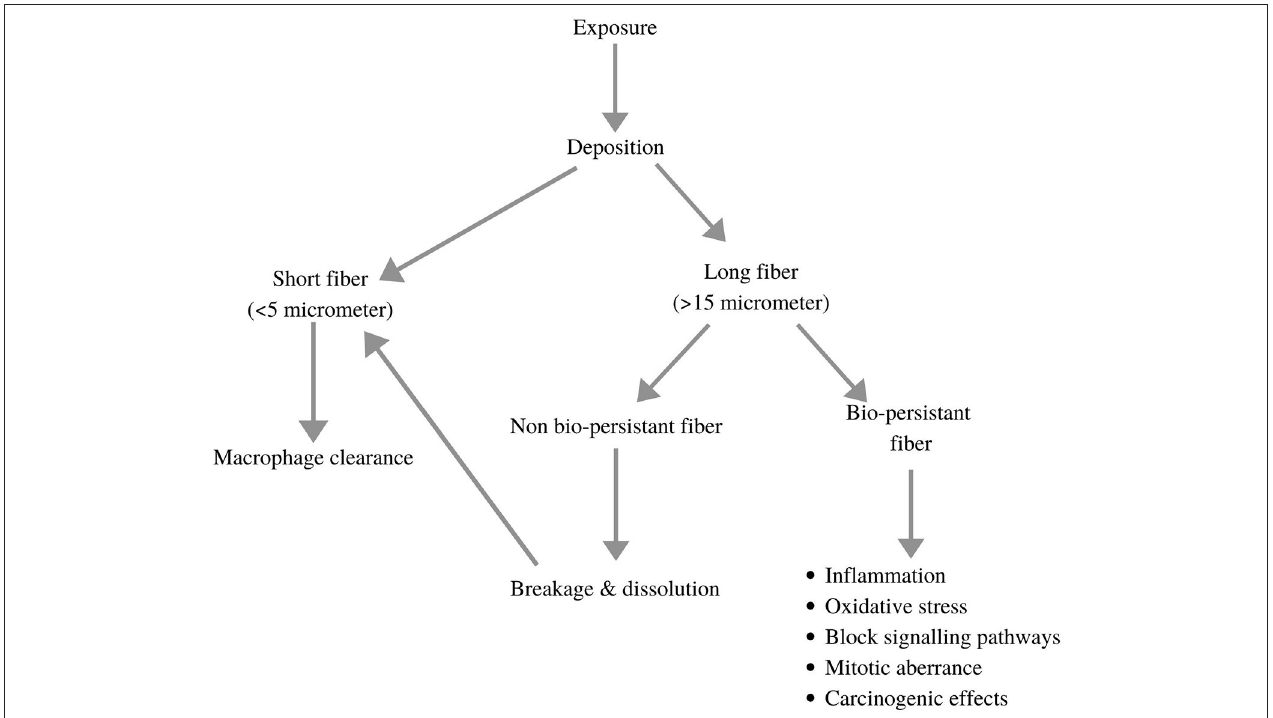
FIGURE 2 | Demonstration of clearance and deposition mechanisms of NP fibres and with their potential impacts on human body (adopted and modified from Donaldson et al.,